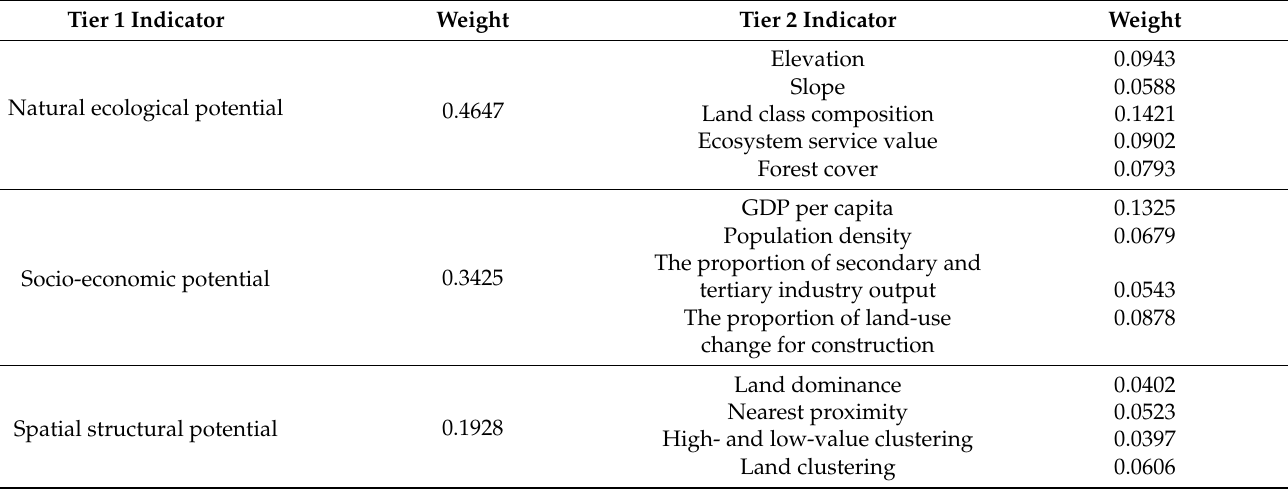
Table 4. Indicator weights results.